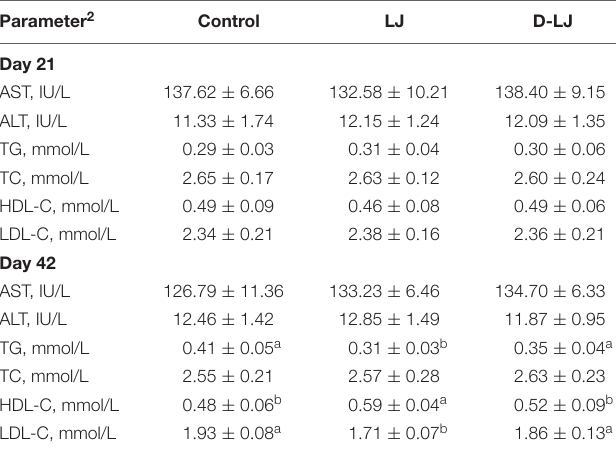
TABLE 6 | Effects of L . johnsonii BS15 on serum biochemical parameters 1 .